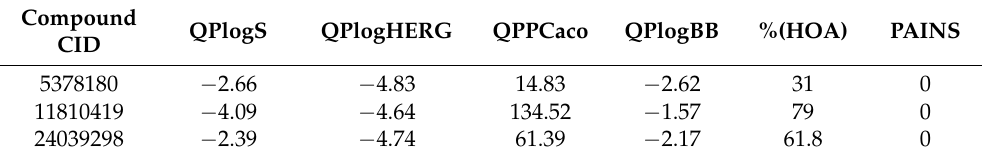
Table 5. Physicochemical descriptors of the selected flavonoids by molecular docking. Compound QPlogS QPlogHERG CID